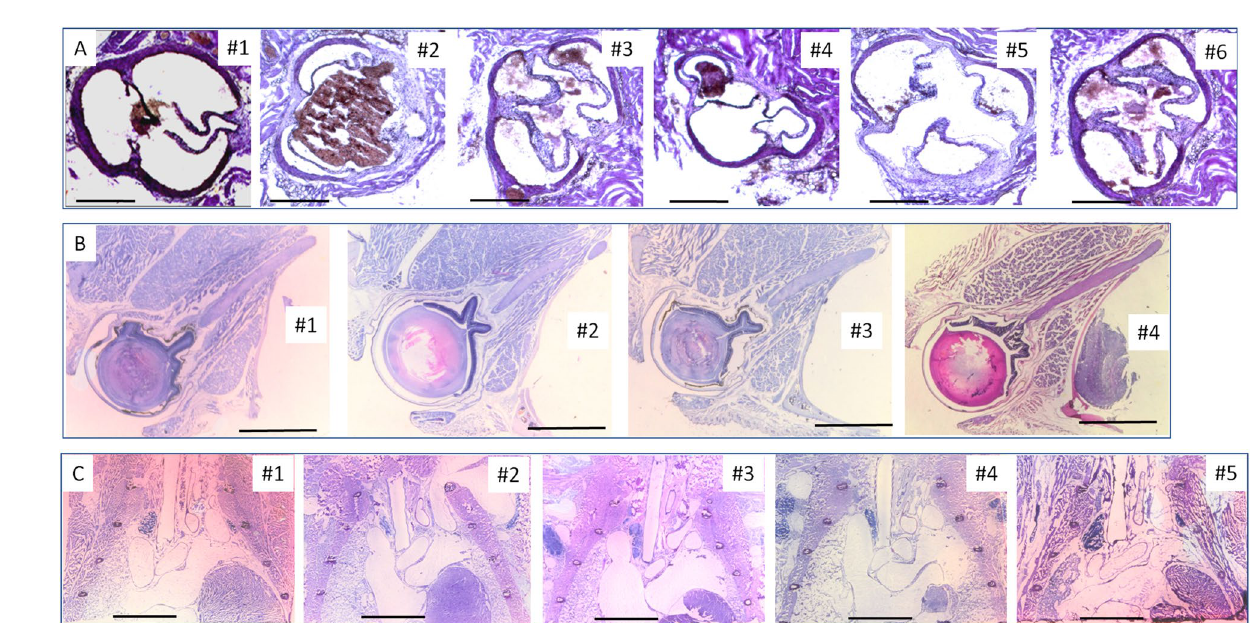
Figure 4. Images of the sections cut at expected cutting-forward distance/places in the paired data-in blocks. The sections cut in data-in paired blocks, containing the whole targets or the lineaments in their central positions are secured, as shown in ( A , B , and C ). ( A ). The sections cut at aortic roots of the hearts in 6 rounds of experiments. Three complete valves are shown in each section. —, indicates 0.5 mm. ( B ). The sections cut in orbits in 4 rounds of experiments. The intraorbital optic nerve between the duct and the connection with the eyeball is shown in each section. —, indicates 2.0 mm. ( C ). The sections cut in thoraxes in 5 rounds of experiments. The thoracic trachea is shown in each section. —, indicates 4.0